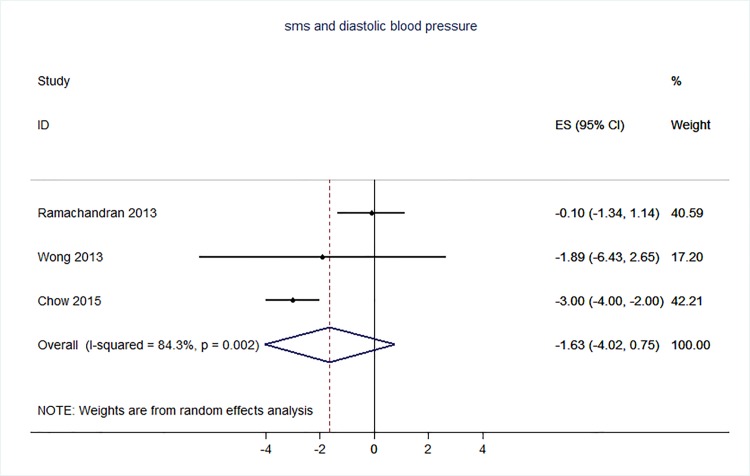
Physical activity and diet interventions using SMS function–diastolic blood pressure (mmHg).